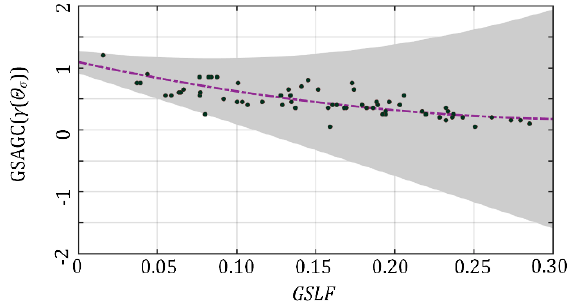
Θ σ ) and GSLF . Confidence interval is